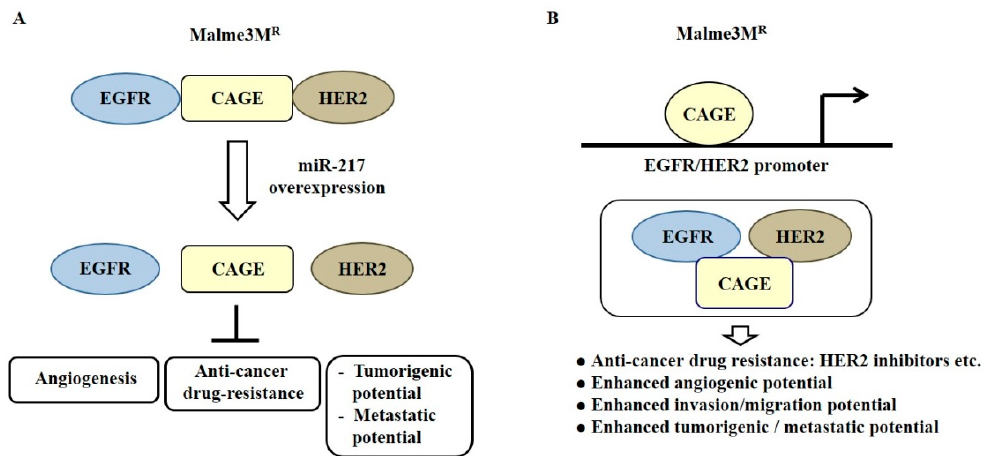
Figure 7. CAGE-miRNA network in anti-cancer drug resistance. ( A ) In anti-cancer drug-resistant cancer cells, CAGE binds to the epidermal growth factor receptor (EGFR) and human epidermal growth factor receptor 2 (HER2). MiR-217 decreases expression of CAGE and disrupts interactions of CAGE with EGFR and HER2. ( B ) In anti-cancer drug-resistant cancer cells, CAGE binds to the promoter sequences of HER2 and EGFR. This results in increased expression levels of EGFR and HER2. The CAGE-HER2-EGFR complex in Malme3M R cells confers anti-cancer drug resistance. The T-bar arrows denote negative regulation and hollow arrows denote positive regulation.